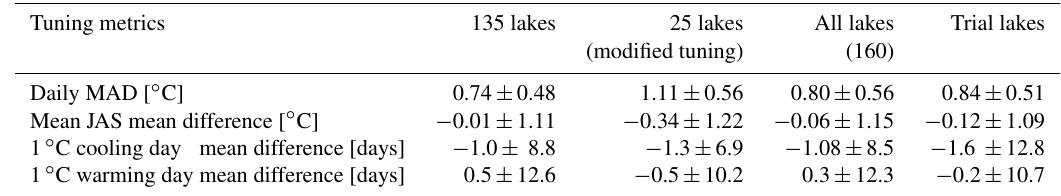
Table 6. Comparison of metric results for seasonally ice-covered lakes: 135 lakes tuned using the initial tuned set-up for seasonally ice- covered lakes (Table 2), 25 lakes tuned with the modified set-up (Table 2), all lakes, and trial lakes. The spread of differences across lakes is defined as 2 σ . The metrics are explained in Table 4. Units are given in square